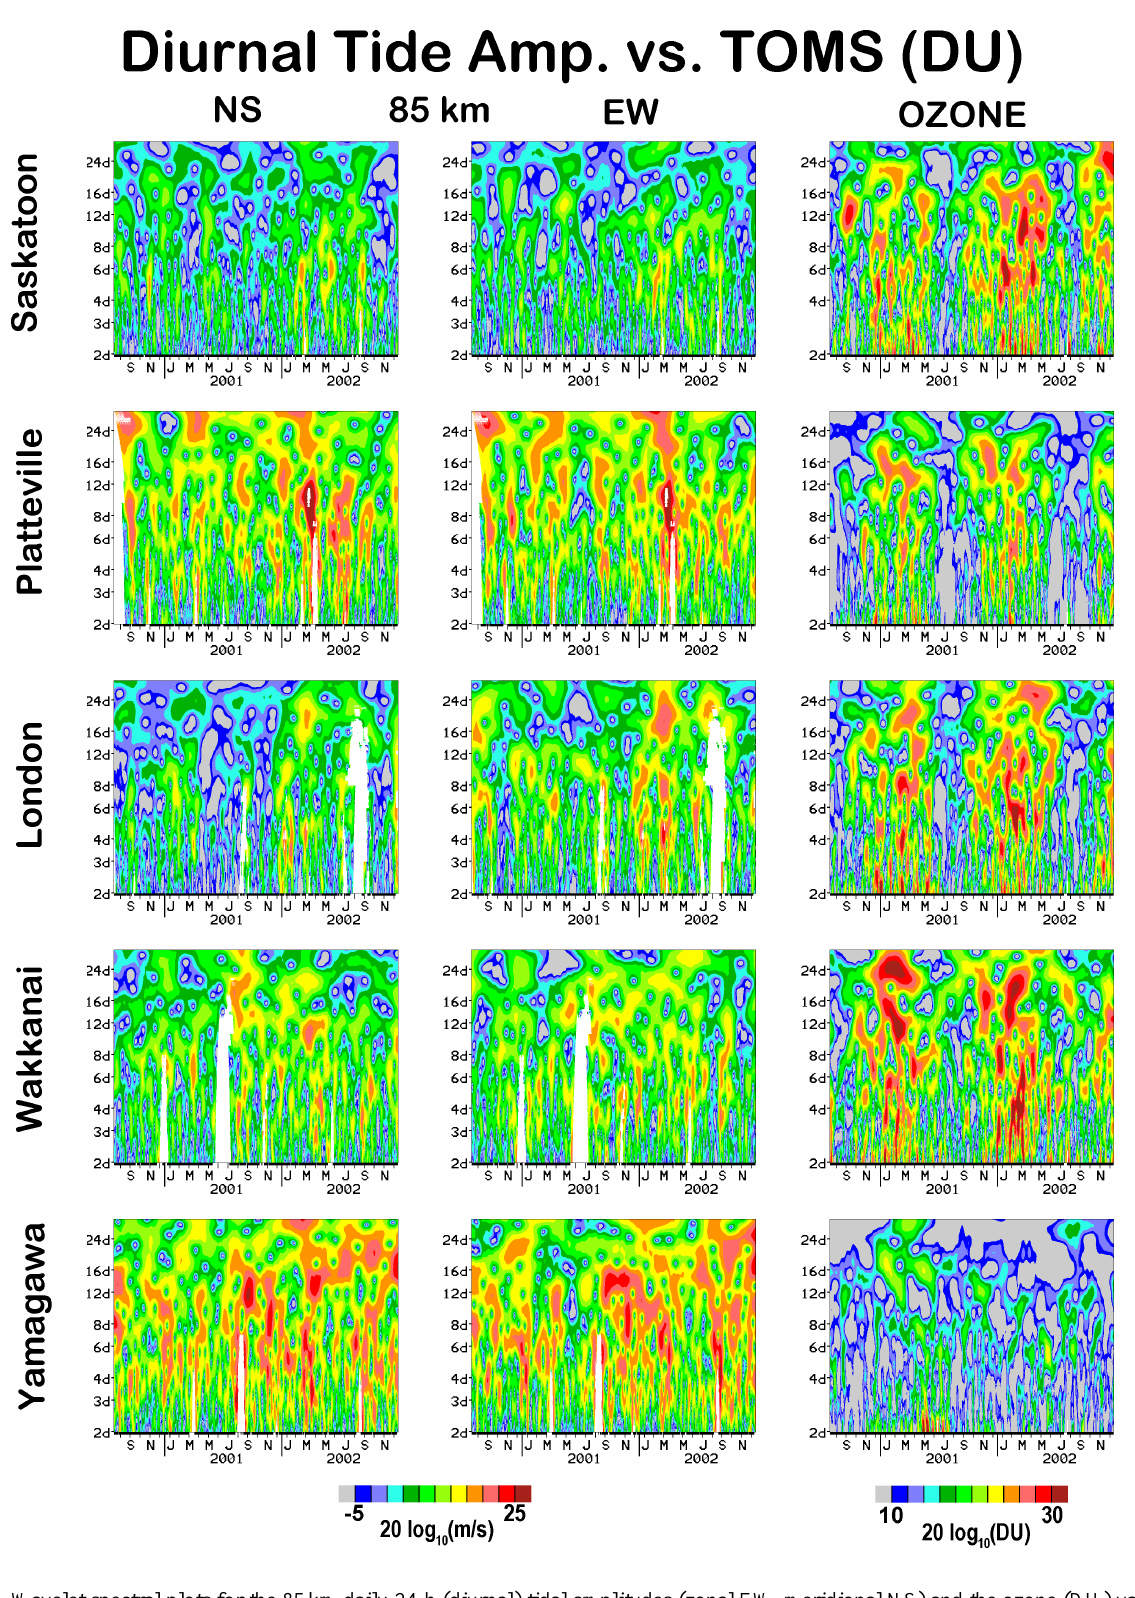
Fig. 4. Wavelet spectral plots for the 85km daily 24-h (diurnal) tidal amplitudes (zonal EW, meridional NS) and the ozone (DU) values of TOMS for the radar locations of CUJO